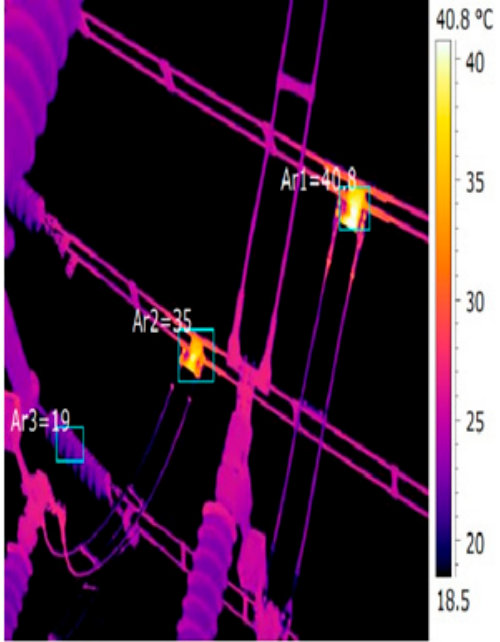
Figure 1. Sample thermal image with hot and cold points. Energies 2017 , 10 , 1987